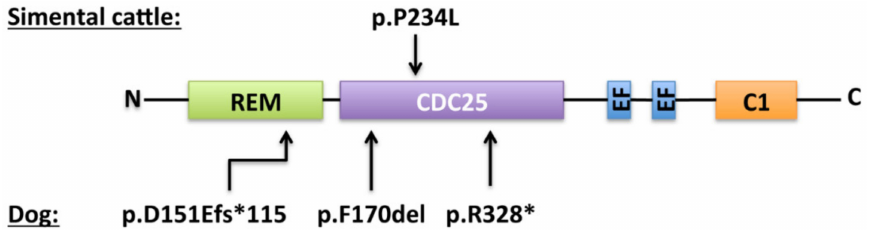
Figure 3. Localization and predicted consequence of the RASGRP2 reported variants in Simmental cattle and dog. Sequences of the variants are annotated according to the consensus nomenclature to describe variant e ff ect at the protein level (fs = frameshift, del = deletion, * = change to a stop